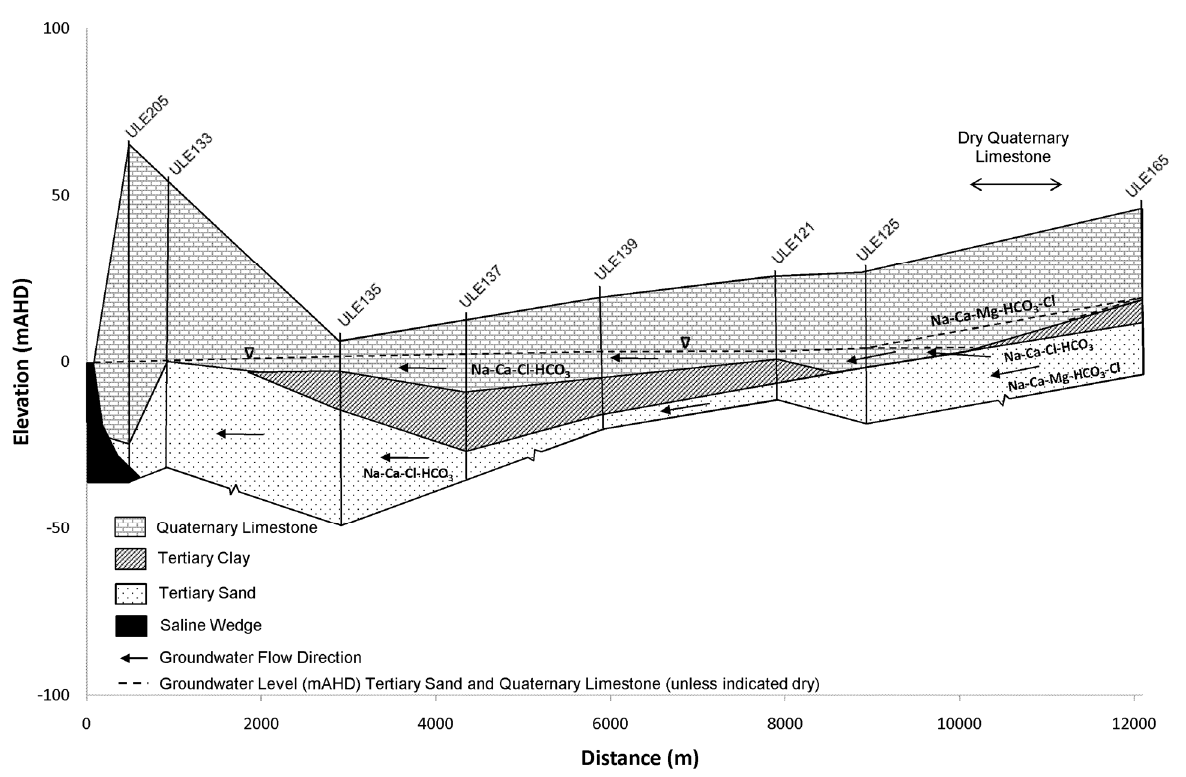
Figure 4. Cross section AA—Uley South basin